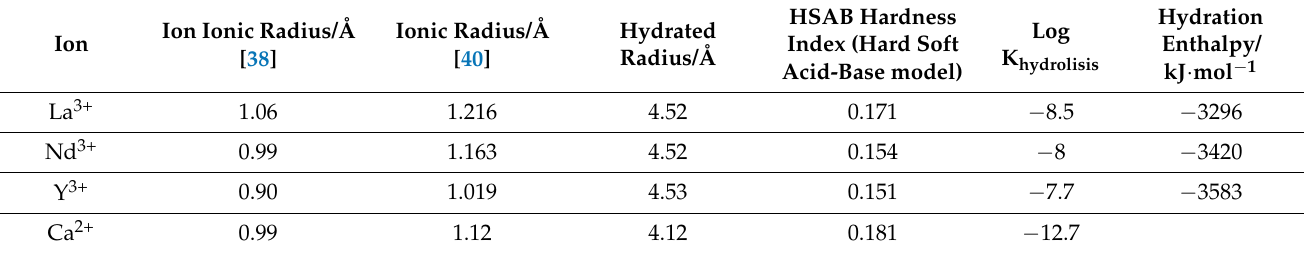
Table 1. Metal properties